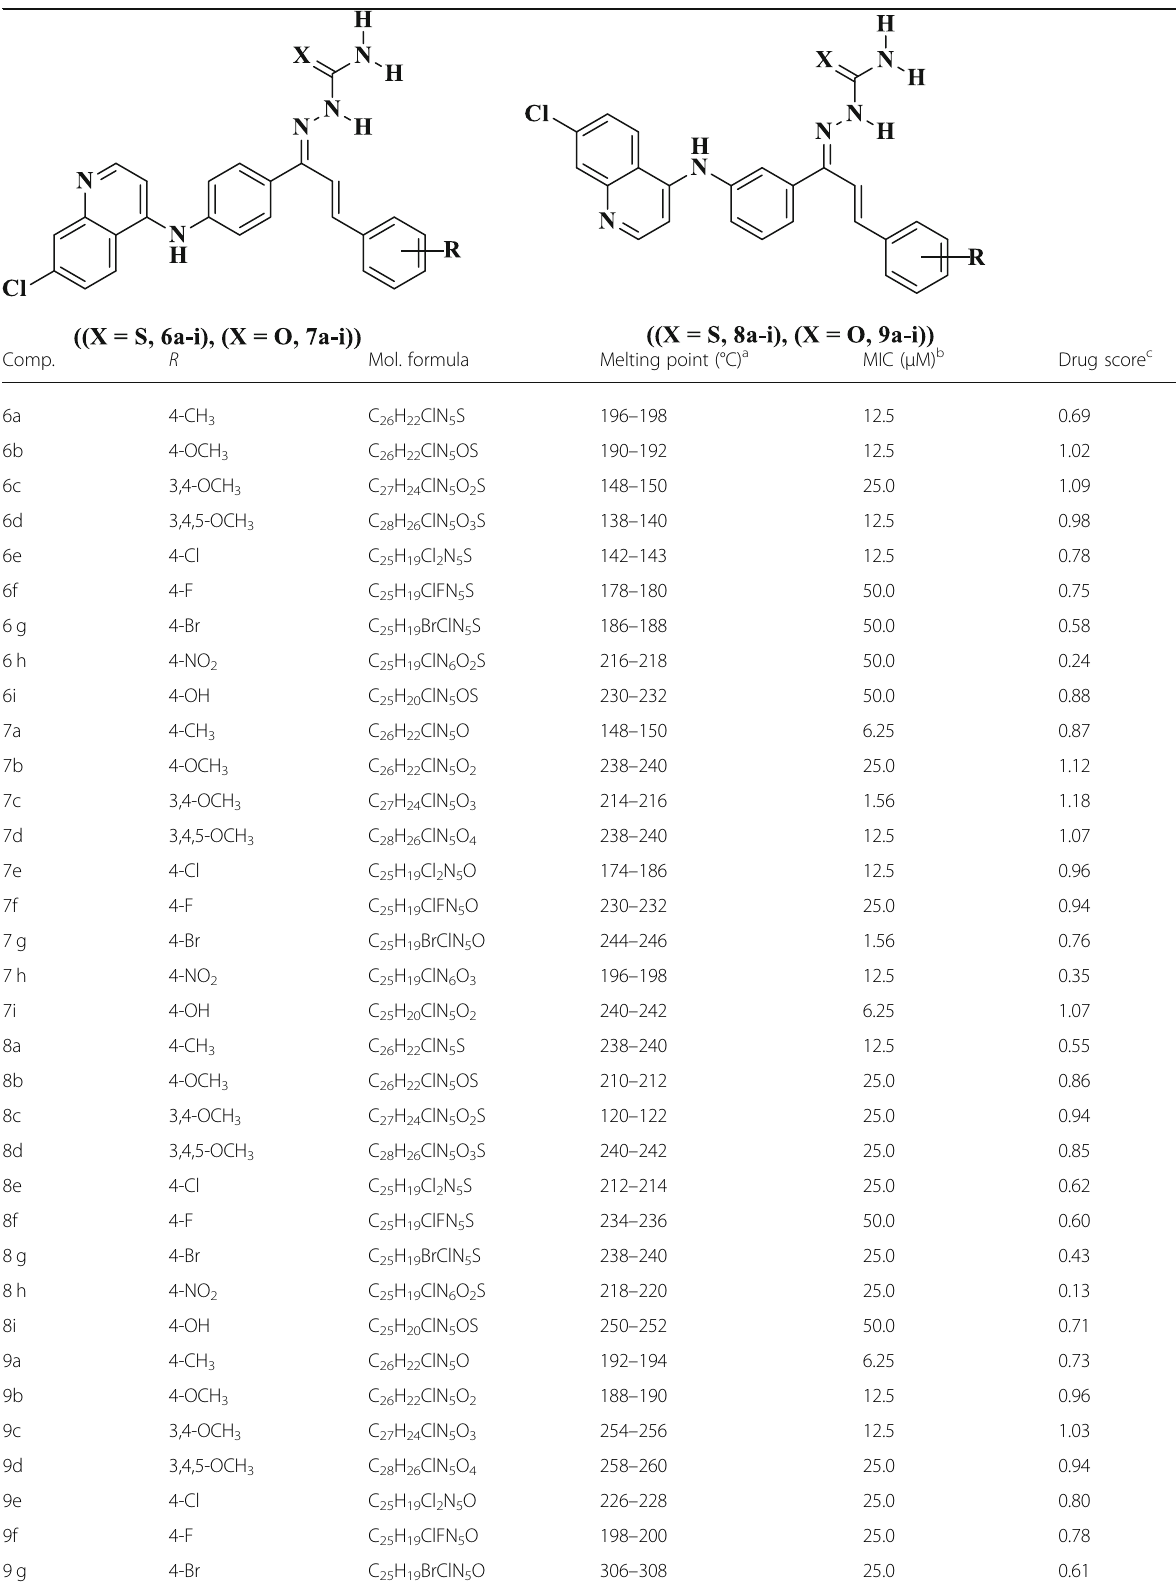
Table 1 Physical data and antimycobacterial activities of compound ( 6a-i ), ( 7a-i ), ( 8a-i ), and ( 9a-i ) against MTB H 37 Rv